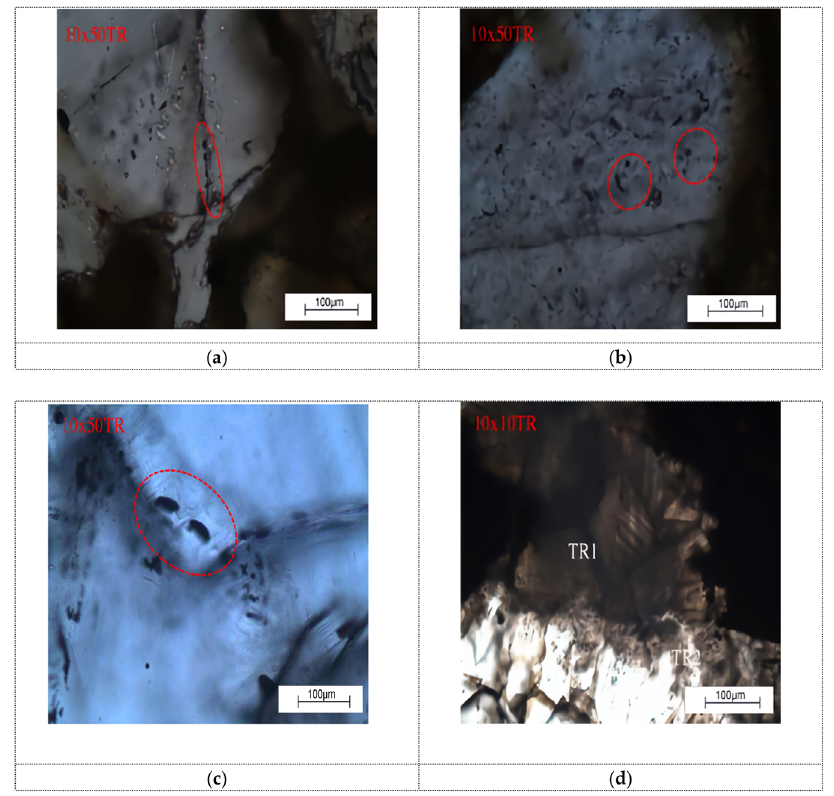
Figure 3: Micrograph of inclusions under transmitted light. ( a ) Inclusions detected in cracks penetrating quartz grains; ( b ) fl uid inclusions in cracks in quartz particles; ( c ) fl uid inclusions in calcite fi lled with limestone fractures; and ( d ) calcite veins cut each other in